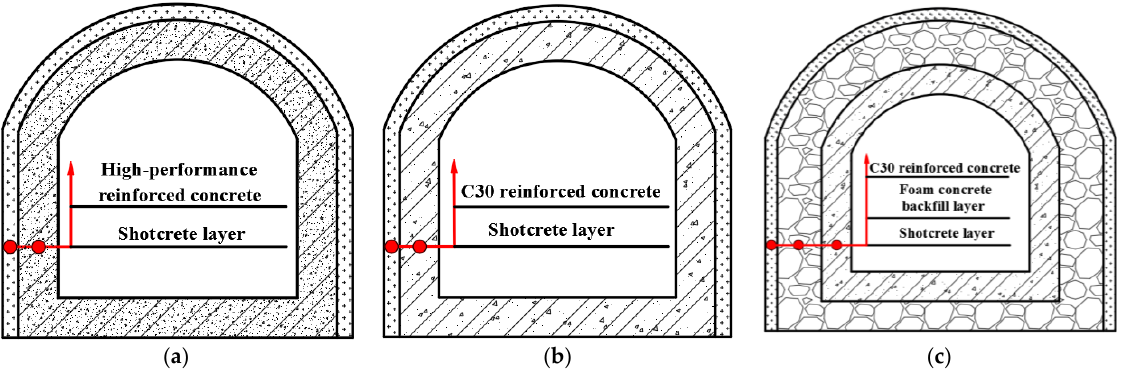
Figure 3. The schematic diagrams of the cross-sectional dimensions of each test section: ( a ) cross-section of test section A; ( b ) cross-section of test section B; ( c ) cross section of test section C.